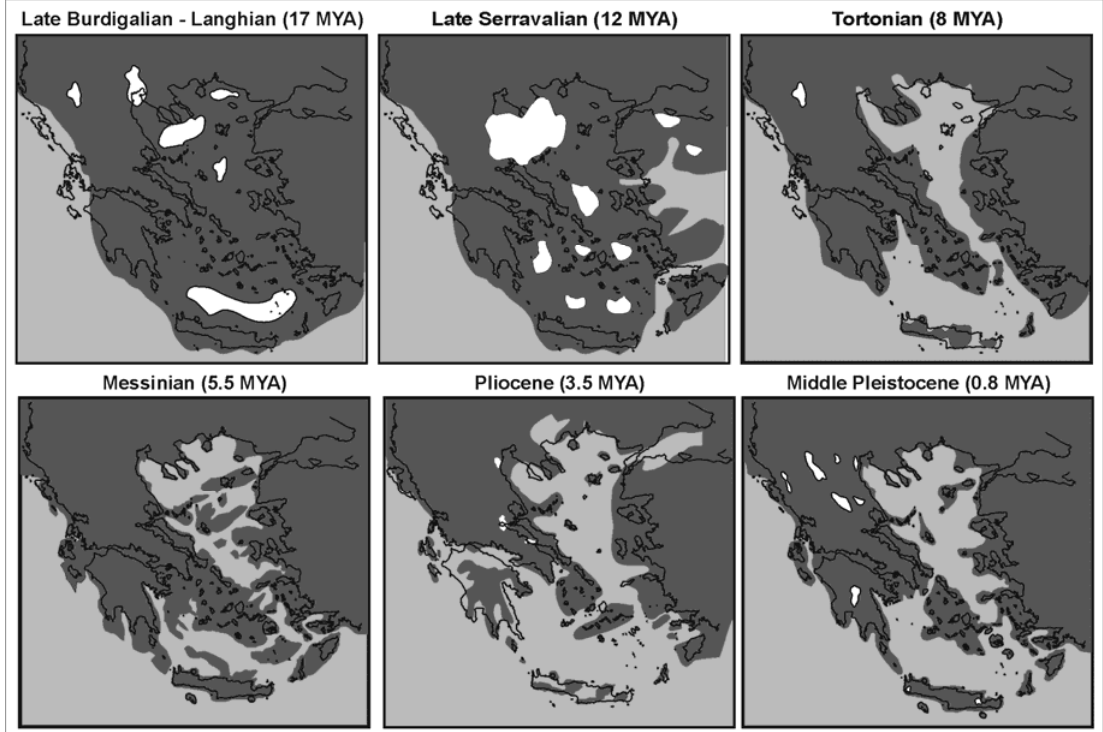
Figure 2. Palaeogegraphic reconstruction of the Aegean area from the late Burdigaldian until the mid Pleistocene. For details and references see